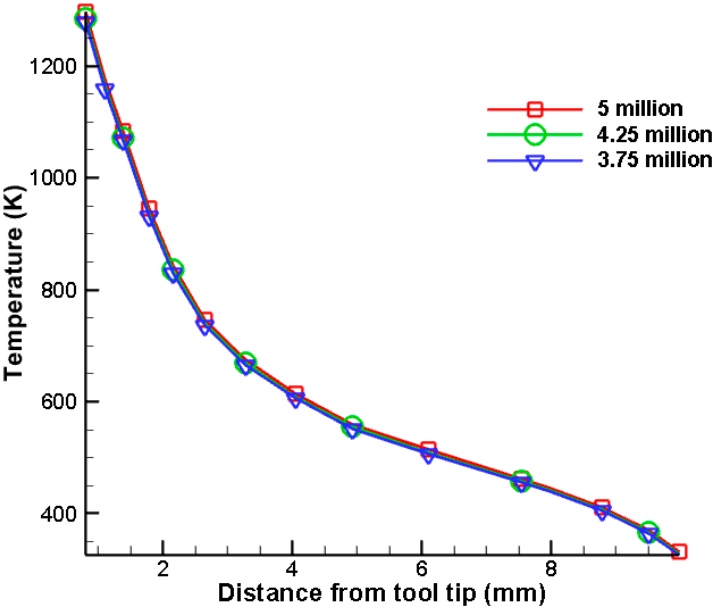
Figure 3. Grid independency test showing the temperature distribution from the tool tip for three different grid sizes.